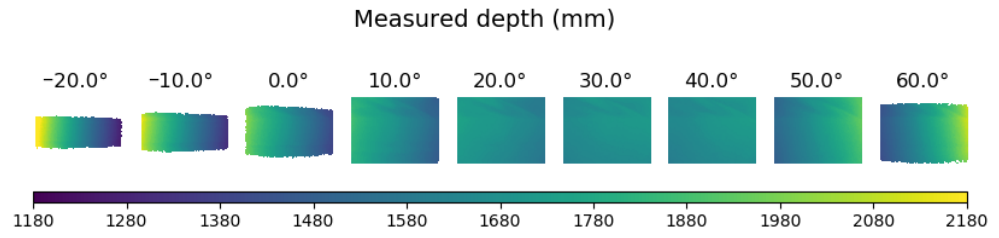
Figure 3. The depth maps obtained at different temperatures. The target object was at 1600 mm.